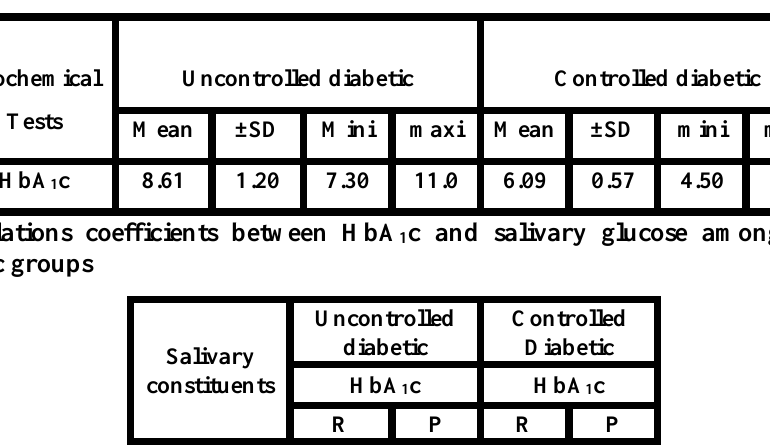
Table (1): HbA c (%( (mean and standard deviation) among uncontrolled and controlled diabetic 1 groups.